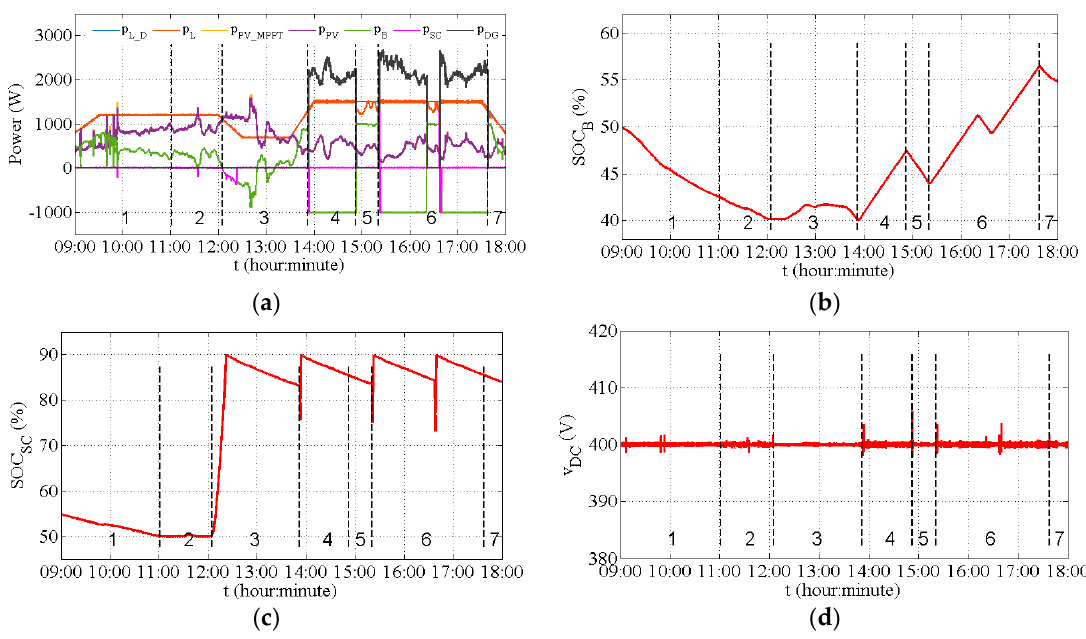
Figure 6. Experimental results of test 1 with the diesel generator (DG) in duty-cycle mode: ( a ) DC microgrid power evolutions, ( b ) SOC evolution of electrochemical battery bank, ( c ) SOC evolution of the SC and ( d ) DC bus voltage.